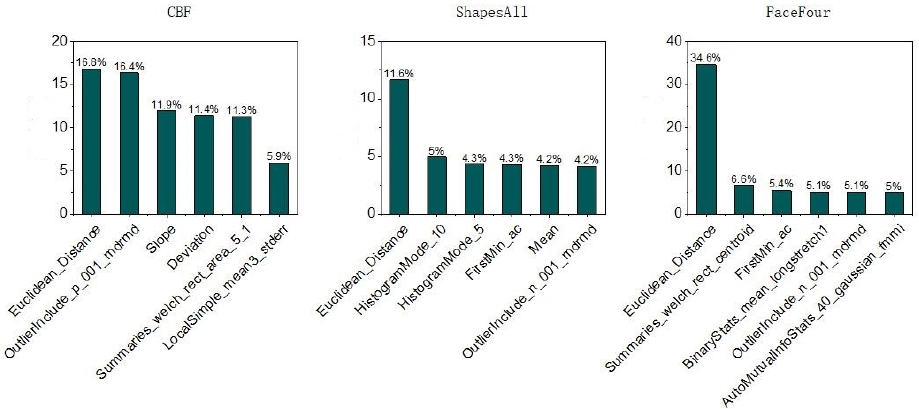
Figure 10. Feature contribution comparisons on three UCR datasets CBF , ShapesAll and FaceFour.